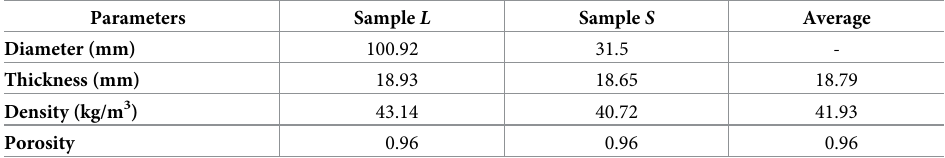
Table 2. Geometric and physical parameters of the samples.